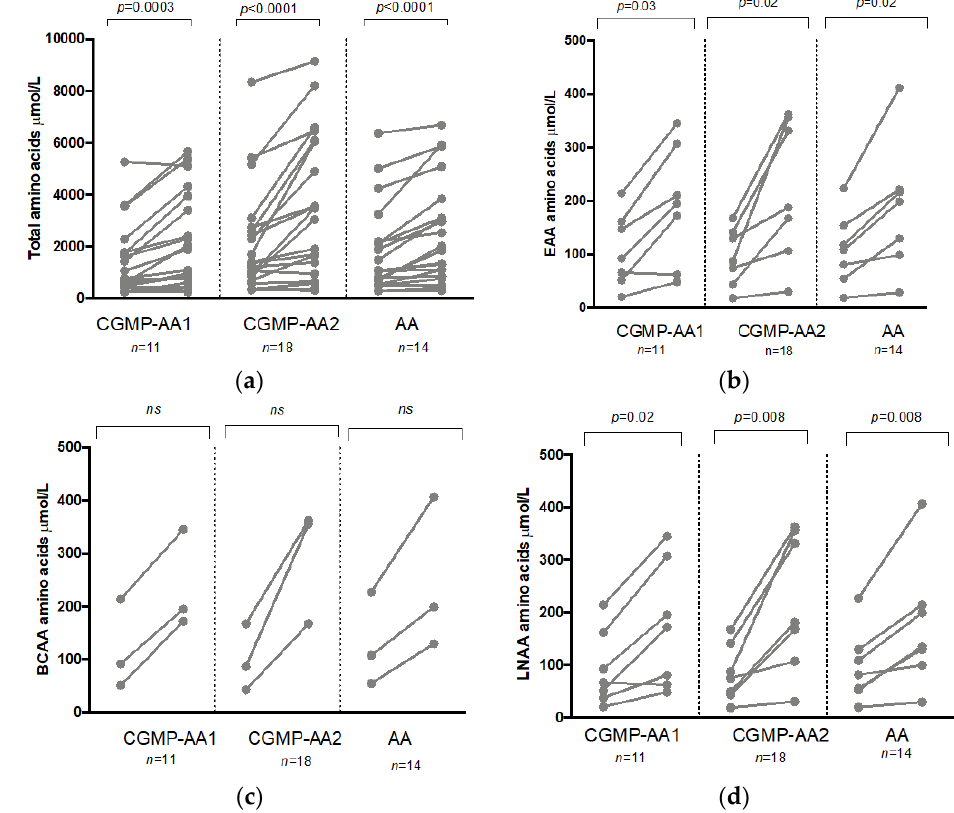
Figure 1. ( a ) Total median pre and postprandial amino acid concentrations for total amino acids ( n = 17) for CGMP-AA1, CGMP-AA2, and PHE-FREE AA protein substitutes. ( b ). Total median pre and postprandial amino acid concentrations for EAA ( n = 7) for CGMP-AA1, CGMP-AA 2, and PHE-FREE AA protein substitutes. ( c ) Total median pre and postprandial amino acid concentrations for BCAA ( n = 3) for CGMP-AA1, CGMP-AA2, and PHE-FREE AA protein substitutes. ( d ) Total median pre and postprandial amino acid concentrations for LNAA ( n = 8) for CGMP-AA1, CGMP-AA2, and PHE-FREE AA protein substitutes.